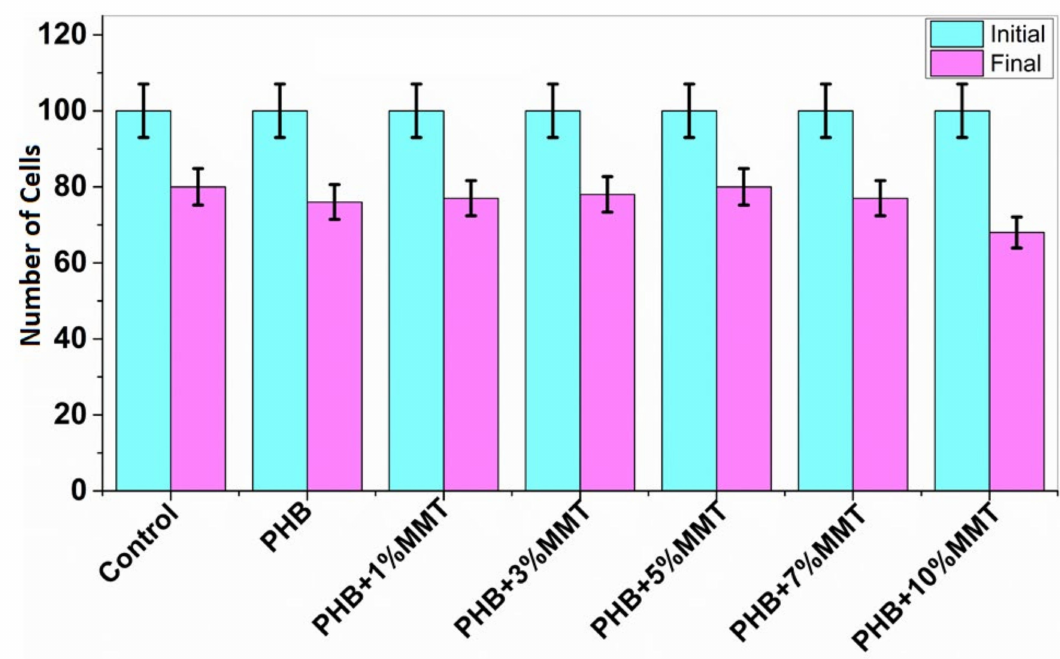
Figure 9. Cytotoxicity study results with the initial and final number of cells in the presence of different nanocomposites.